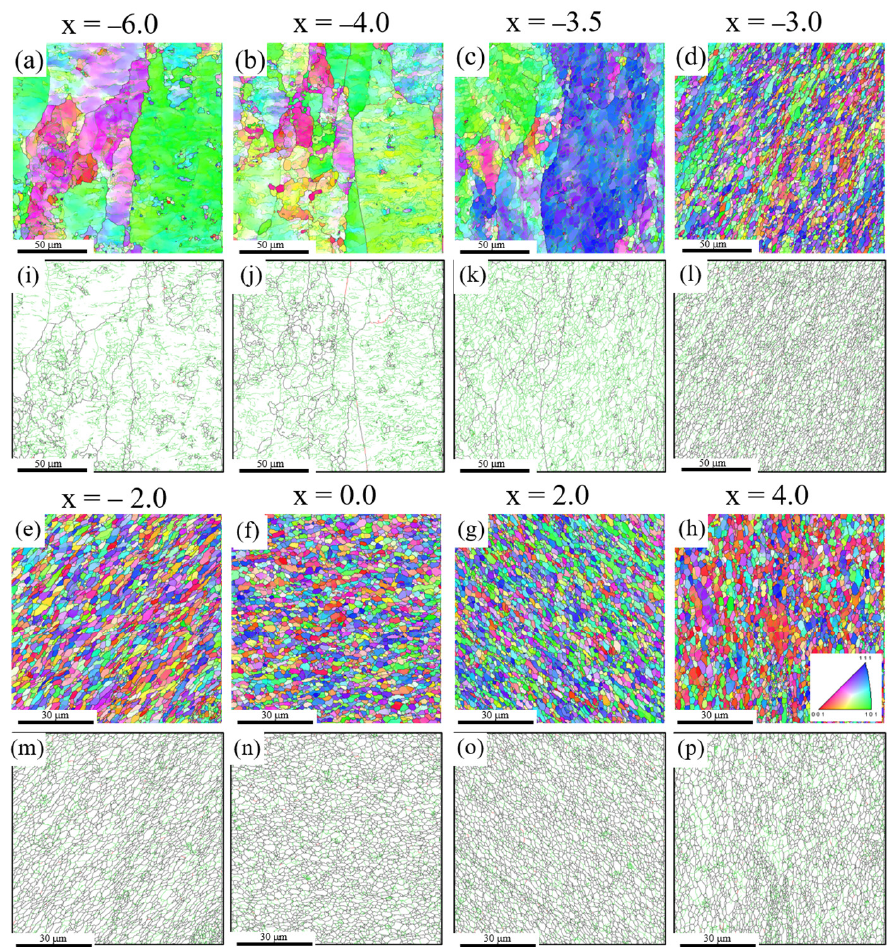
Figure 3. ( a – h ) IPF and ( i – p ) grain boundary maps for the pure Al joint at 0.56 T m in the range of –6 < x < 4. Black and green lines denote HABs and LABs, respectively.